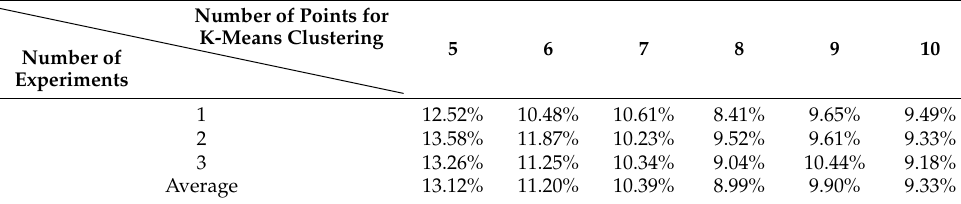
Table 1. Percentage of narrow triangles after global ocean unstructured grid